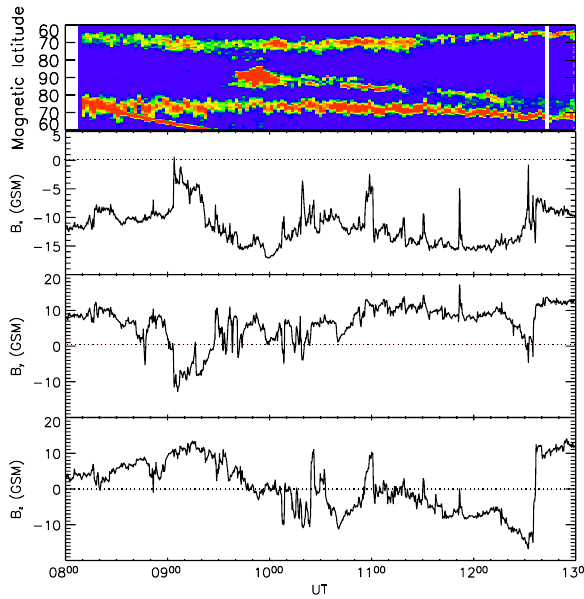
Fig. 3. (a) Keogram presentation of the transpolar arc observed by the IMAGE FUV/WIC along the noon-midnight meridian. (b) IMF clock angle.